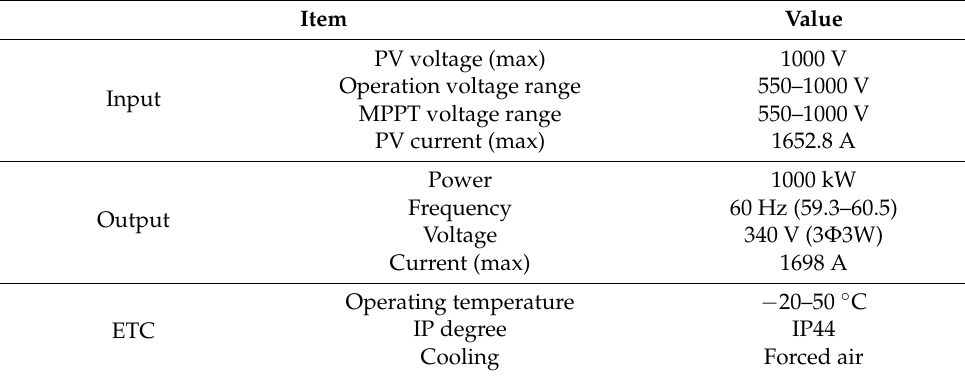
Figure 10. Image of the 1 MW PV inverter system. Table 5. Specification of the 1 MW PV inverter system. Table 5. Specification of the 1 MW PV inverter system.